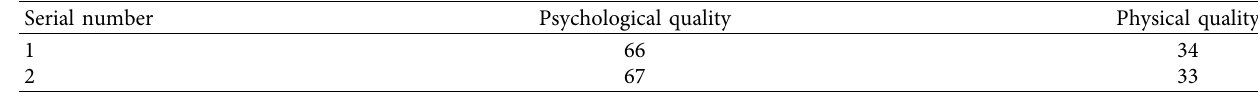
Table 5: Physical psychological